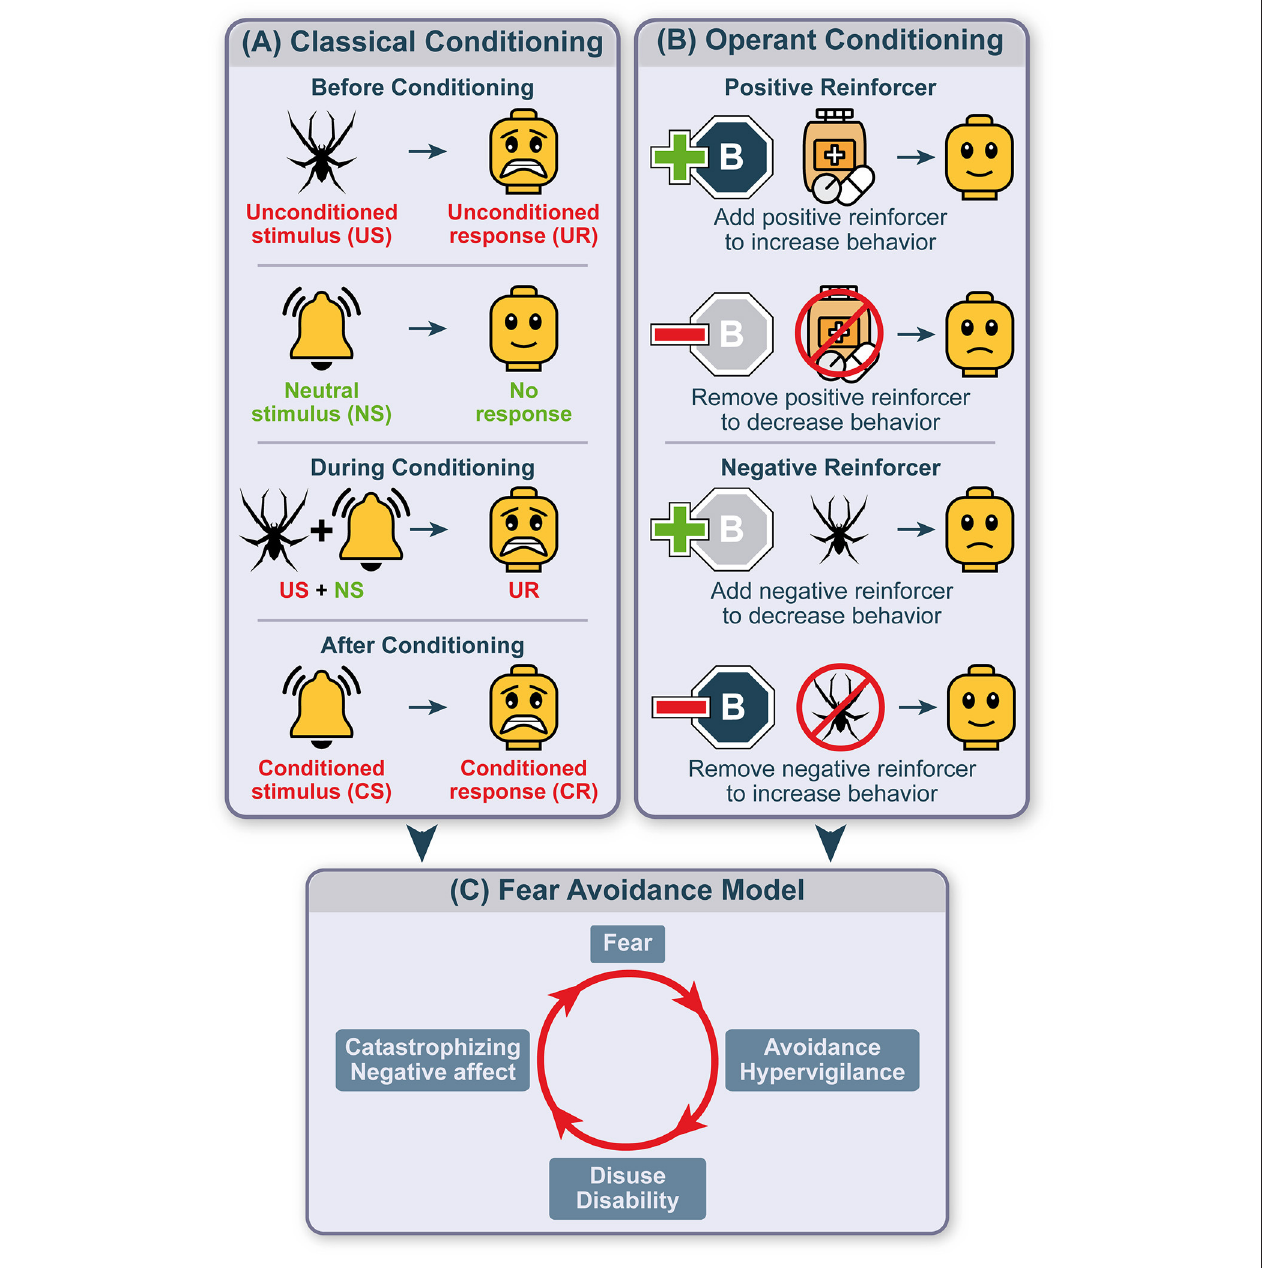
FIGURE 1 | Avoidance within the conceptual framework of learning theory. Schematic depiction of avoidance embedded within the conceptual framework of classical conditioning initiating a fear response and mechanisms of operant conditioning fueling avoidance and maintaining maladaptive behaviors. Classical conditioning (A) refers to learning of an association between two stimuli. The unconditioned stimulus (US) naturally and automatically evokes an unconditioned response (UR) while neutral stimuli (NS) usually evoke no response. When associating the unconditioned with the neutral stimulus, the individual will display the unconditioned response. This association will turn the neutral into a conditioned stimulus (CS) evoking a conditioned response (CR). After a CS-US relationship is established, the behavior of an individual will be adapted based on its consequences. This operant conditioning (B) is formed by adding or removing a reinforcing stimulus that increases or decreases the probability of a specific behavior to occur in the future. A positive reinforcer increases the probability to show a certain behavior while its withdrawal discourages it. Adding a negative reinforcer decreases behavior while removing the negative reinforcer encourages the behavior to be displayed. These two processes combine to form a vicious circle of fear avoidance (C). Upon the encounter of a fear-relevant stimulus, a vicious circle of fear avoidance is initiated by increasing attentional resources to potential sources of threat (hypervigilance), disuse and disability and exaggerating negative thoughts and affect (catastrophizing), thereby preventing the encounter with the feared stimulus and corrective